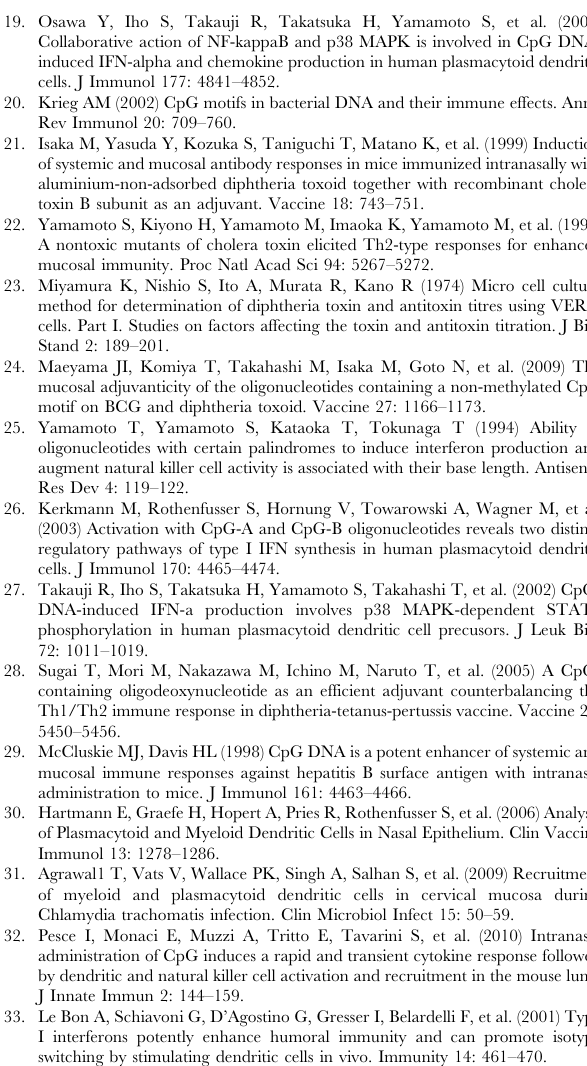
Figure S3 G9.1 suppressed ovalbumin-induced allergic reaction. Male BALB/c mice received an i.p. injection of 10 m g of ovalbumin (OVA) in alum on days 0 and 21 and were challenged on day 35 with an i.c. injection of PBS, 5 m g of OVA, or 5 m g of OVA plus 50 m g of G9.1 (into the ear). One day later, ear thickness was measured and histological and